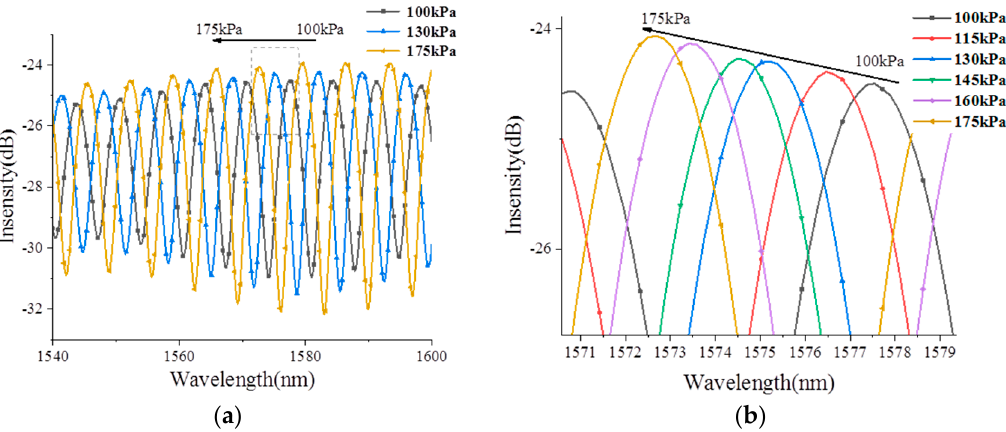
Figure 9. Spectrum characteristics of sensor S2. ( a ) Spectrum range from 1540 to 1600 nm; and ( b ) spectrum range from 1565 to 1573 nm.